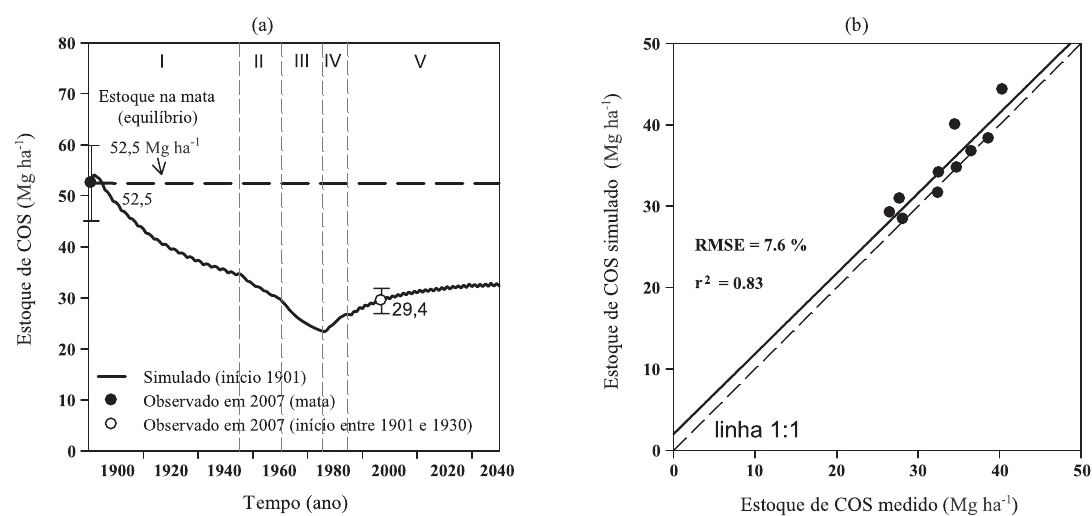
Figura 4. (a) simulação de calibração principal do modelo century considerando a conversão de floresta em agricultura em 1901 na área 1 e diferentes cenários de manejo do solo (i- colonial 1; ii: colonial 2; iii: preparo convencional; iv: preparo reduzido; v: plantio direto “atual”) e (b) validação das estimativas do modelo a partir dos estoques de cos medidos e simulados em 2007 em lavouras sob latossolo de topo no distrito santana, ijuí - rs (r = 0,91; rMse = 7,6%; rMse_95 % limite de confiança = 13,8 %; Me = 0,67).